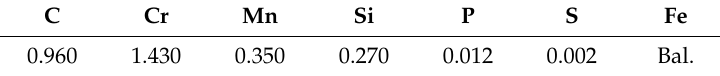
Table 1. The chemical composition of GCr15 bearing steel (wt